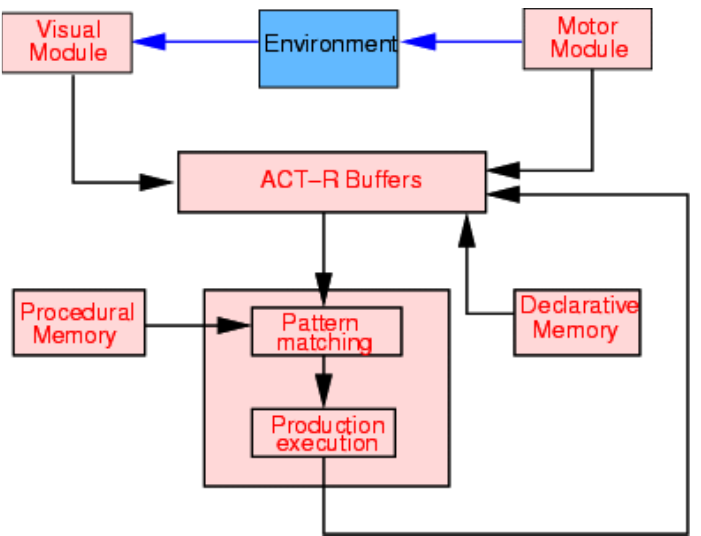
Figure 2. Schematic representation of the ACT-R cognitive architecture. Reproduced, with permission, from the ACT-R website, http://act-r.psy.cmu.edu/about/act-r.psy.cmu.edu/about/ (accessed on 1 July